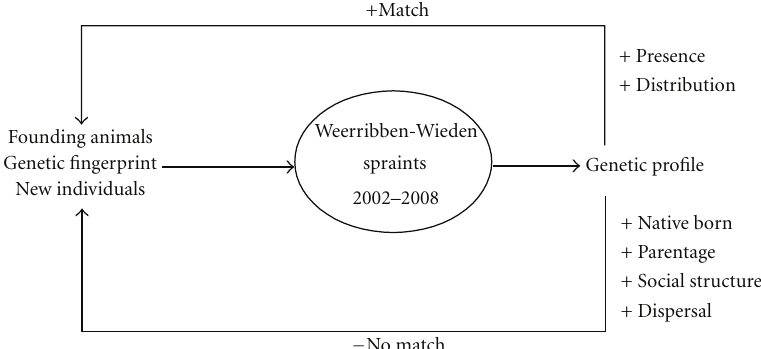
Figure 5: The setup and aim of the genetic monitoring plan. All founding animals ( n = 31) were genotyped before they were released. Since we are working with a small, isolated population (i.e., e ff ectively closed), the whereabouts of the animals could, during the first years of the studies (period 2002–2008), be traced by careful sampling and DNA extraction from the collected faeces (spraints). A positive match indicates the presence and distribution of known animals, in first instance founding animals but later on also successfully recruited o ff spring of the founding animals. A negative match implies the occurrence of new genetic profiles in the population. In first instance these have to be o ff spring of the founding animals (native borns), but later on these native borns could also descend from mating of previous native borns. Every year of monitoring the reference database with genetic profiles is updated based on the results of the previous year. In this way we were able to compose a detailed life table matrix and genetic pedigree of the reintroduced otter